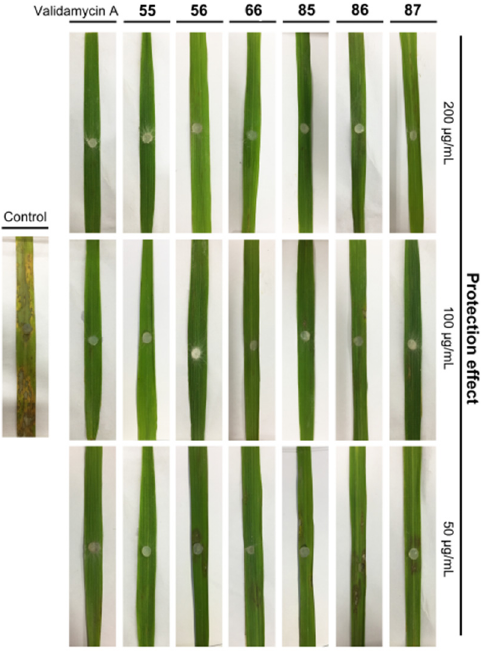
Figure 3. In vivo protective e ff ect of selected compounds against R. solani using detached leaf